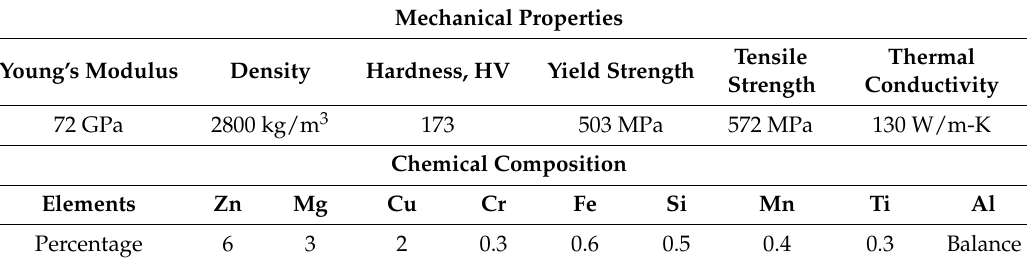
Table 1. Mechanical properties and chemical composition of Al7075. Mechanical